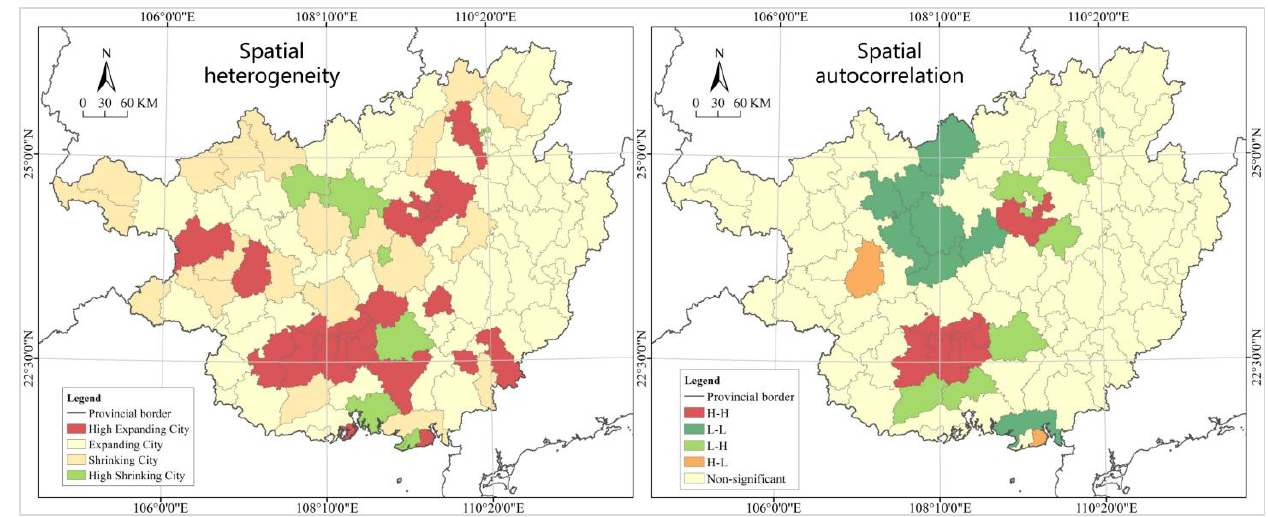
Figure 8. Spatial analysis of urban night lighting index changes in Guangxi .